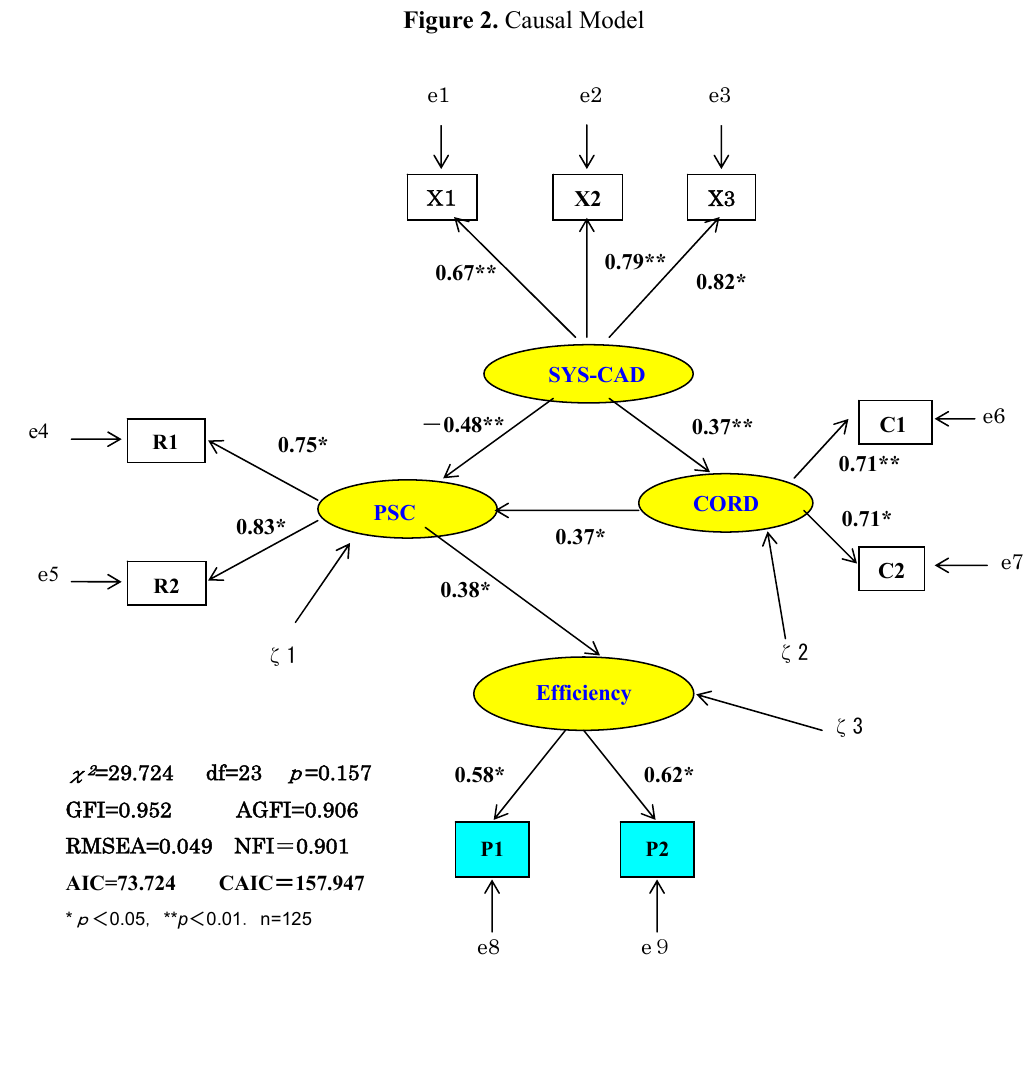
Figure 2. Causal